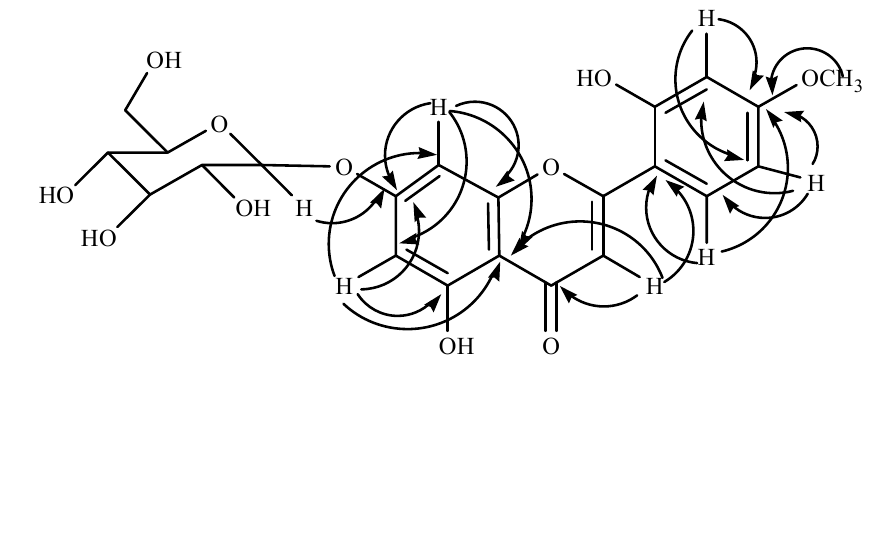
Figure 2. Important HMBC correlations in compound 1